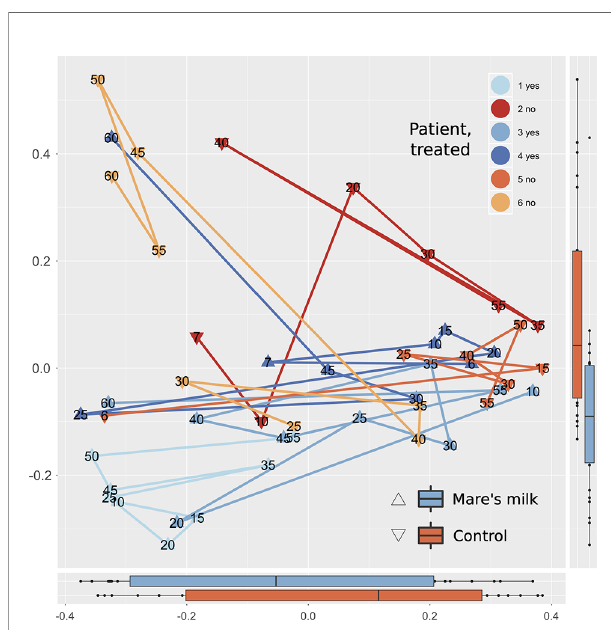
FIGURE 2 | Multivariate analysis of gut composition shifts. Principal Coordinates Analysis (PCoA) of gut composition (samples post-antibiotic only, replicates not shown) analyzed using Bray-Curtis distances applied to rare fi ed gut 16S OTU data. The fi rst two dimensions capturing the data distance space signi fi cantly (PERMANOVA P < 0.001, with parameters in order: intervention, sample ID, swab vs. stool sample, and time point) separates mare ’ s milk-treated samples from controls. Marginal plots show this distribution on both axes, and lines connect labeled time points of samples from the same subject. On the overall level, gut composition post-antibiotics differs between controls and MM-treated